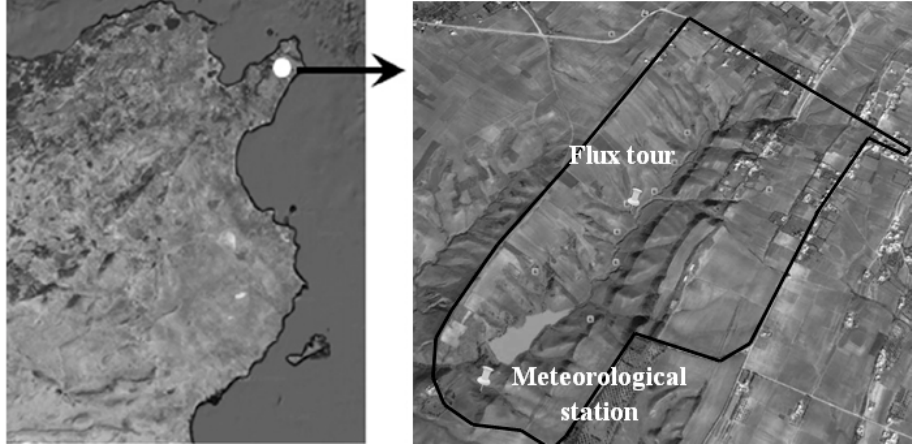
Figure 1. The Kamech watershed. Left : localization of the Kamech watershed in the Cap Bon peninsula, northeastern Tunisia. Right : aerial map of the Kamech watershed with the localization of the flux tour and of the meteorological